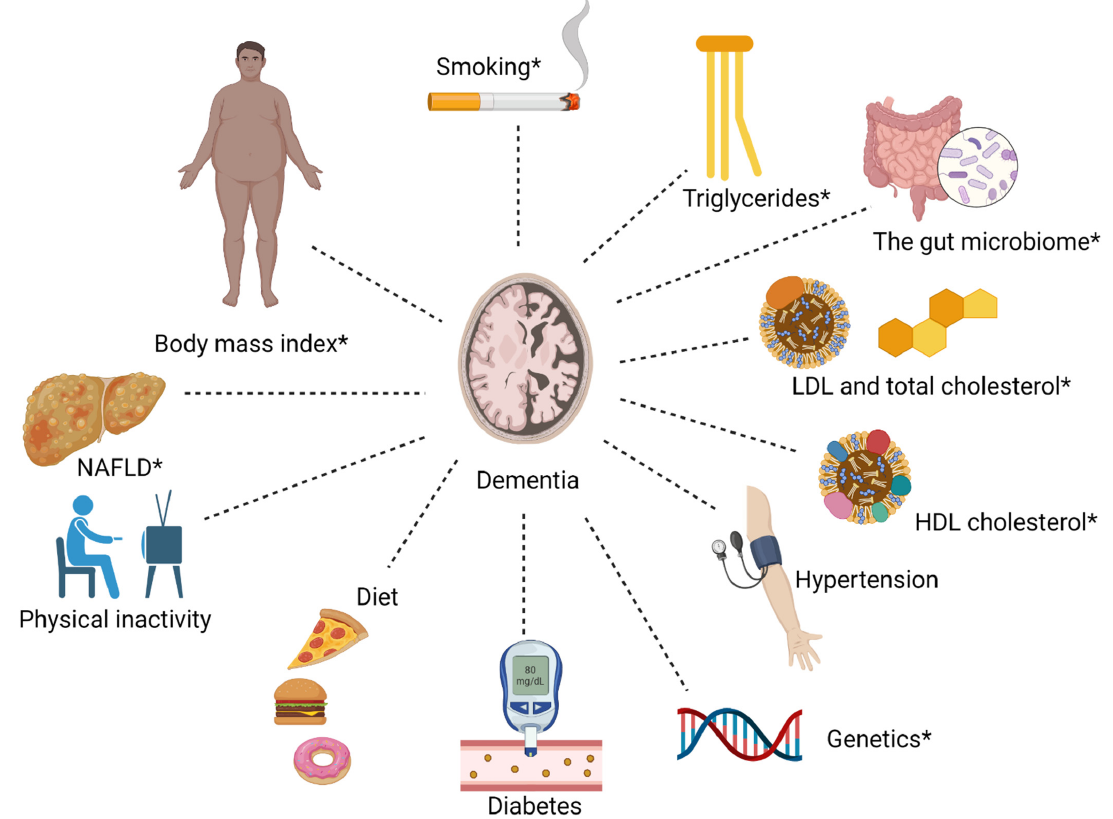
Figure 1. Overview of shared risk factors between dementia and atherosclerotic cardiovascular disease, discussed in this review. LDL, low-density lipoprotein; HDL, high-density lipoprotein; NAFLD, non-alcoholic fatty liver disease. The associations for some risk factors differ between Alzheimer’s disease and non-Alzheimer dementia, specifically, body mass index, triglycerides, HDL cholesterol, NAFLD, the gut microbiome, smoking, and genetics (these are marked by *).